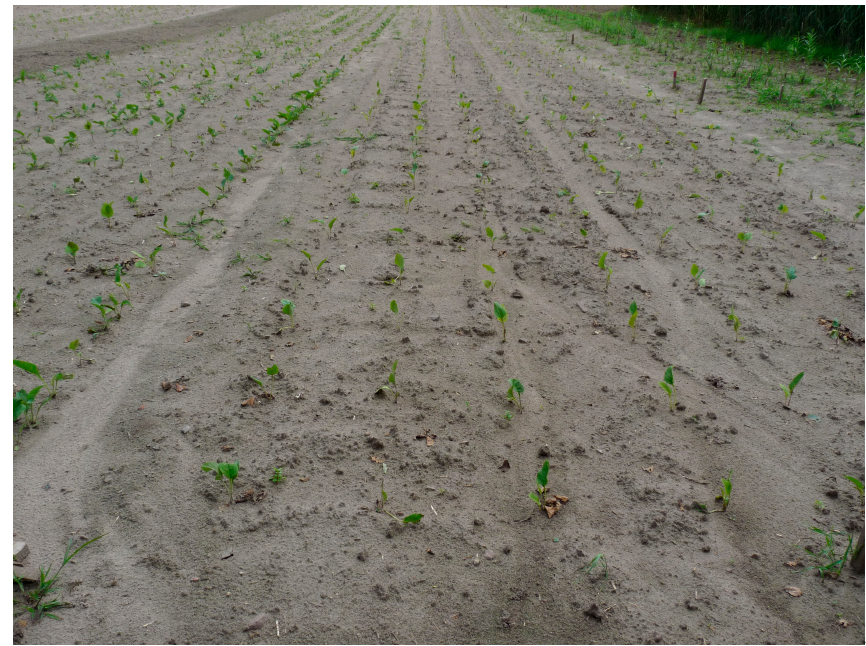
Figure 1. Silphium plants two weeks after transplanting seedlings to the field (planting).